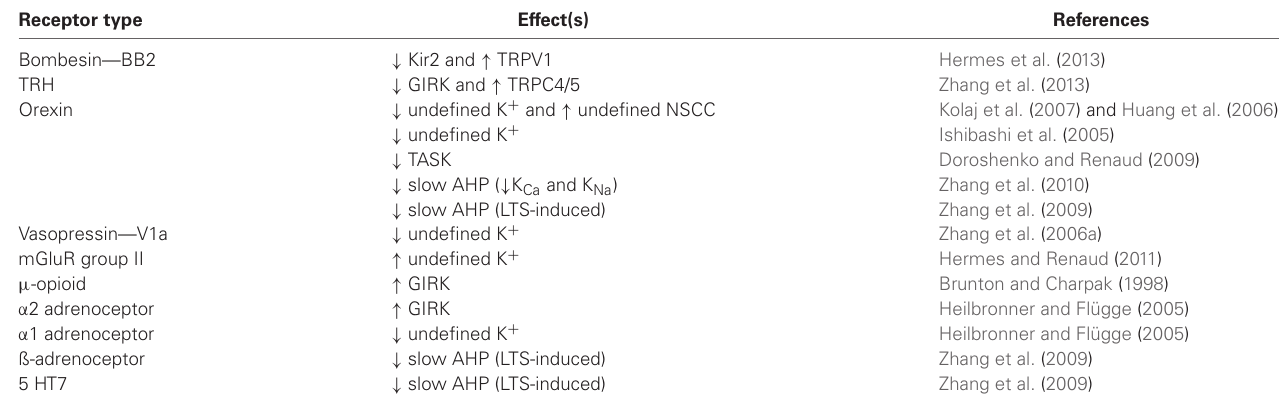
Table 1 | Summary table of electrophysiologically characterized postsynaptic neurotransmitter receptors in PVT neurons. Receptor type